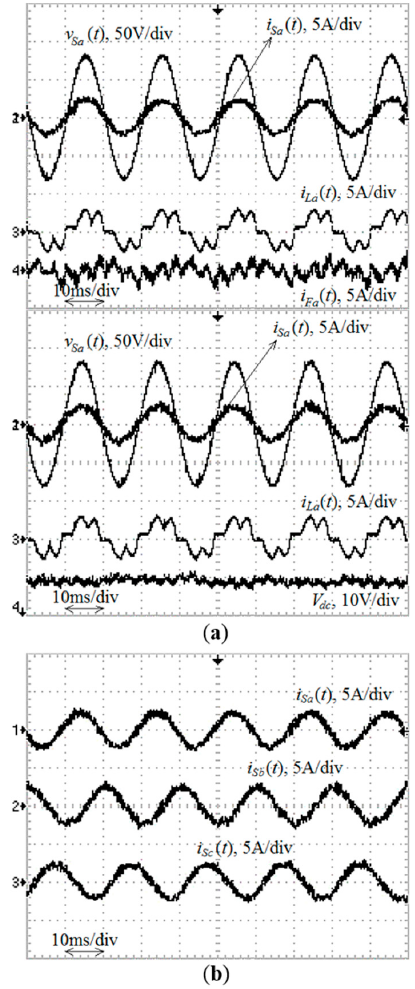
Figure 16. Experimental steady ‐ state ( a ) (cid:1874) (cid:3020),(cid:3028) (cid:4666)(cid:1872)(cid:4667) , (cid:1861) (cid:3020),(cid:3036)(cid:3028) (cid:4666)(cid:1872)(cid:4667) , (cid:1861) (cid:3013),(cid:3036)(cid:3028) (cid:4666)(cid:1872)(cid:4667) , (cid:1861) (cid:3007),(cid:3036)(cid:3028) (cid:4666)(cid:1872)(cid:4667) , (cid:1848) (cid:3031)(cid:3030) and ( b ) 3 ‐ phase (cid:1861) (cid:3020) (cid:4666)(cid:1872)(cid:4667) Figure 16. Experimental steady-state ( a ) v S , a ( t ) , i S , ia ( t ) , i L , ia ( t ) , i F , ia ( t ) , V dc and ( b ) 3-phase i S ( t ) waveforms, using Load 1. waveforms, using Load